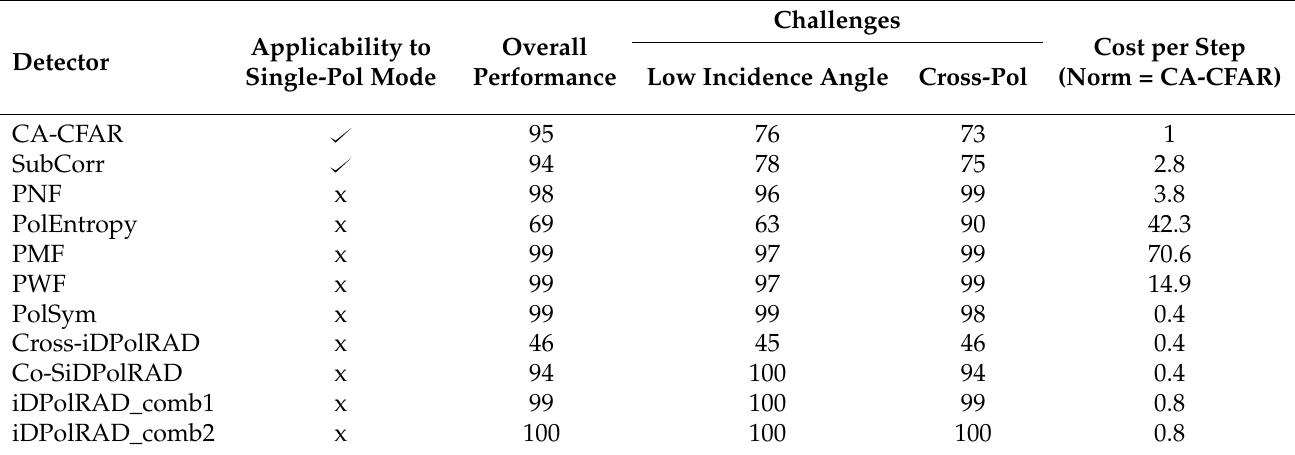
Table 4. Detectors’ performance comparison (pixel-based,